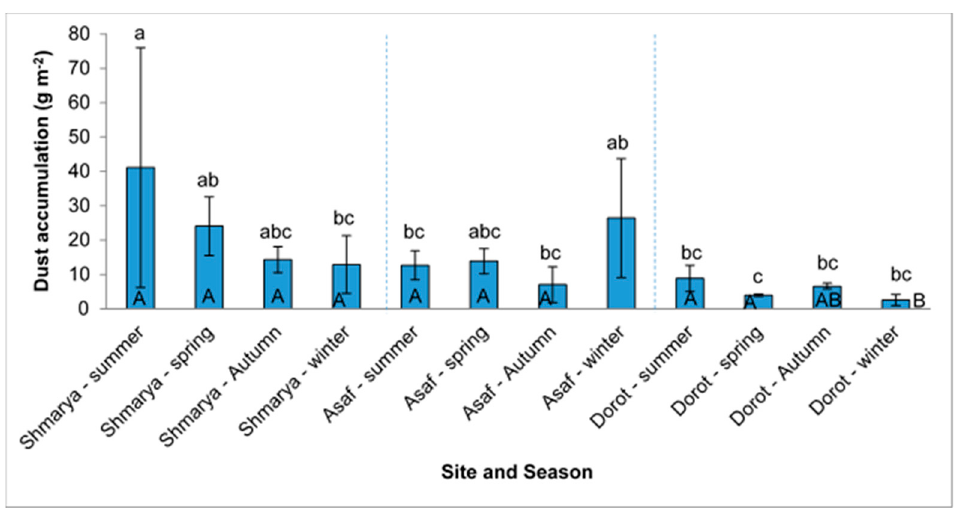
Figure 2. Accumulation of dust in collectors, at each of the three sites, by season (mean ± SE, different letters indicate statistical differences, according to Tukey’s range test, p < 0.05). The letters above the columns indicate statistical differences between all seasons, and sites and the capital letters indicate statistical differences between the seasons within each site. Table 2. Grain ‐ size distribution of the aeolian dust particles with a High ‐ Resolution Laser Diffractometer, (USDA classification of sand sizes for clay, silt, sand) and atmospheric particulate matter (PM) of samples collected at the four sites. 1–3 Shmarya, 4–6 Asaf, 7–9 Dorot and 10–12 Lachish. One sample for each year of the study.